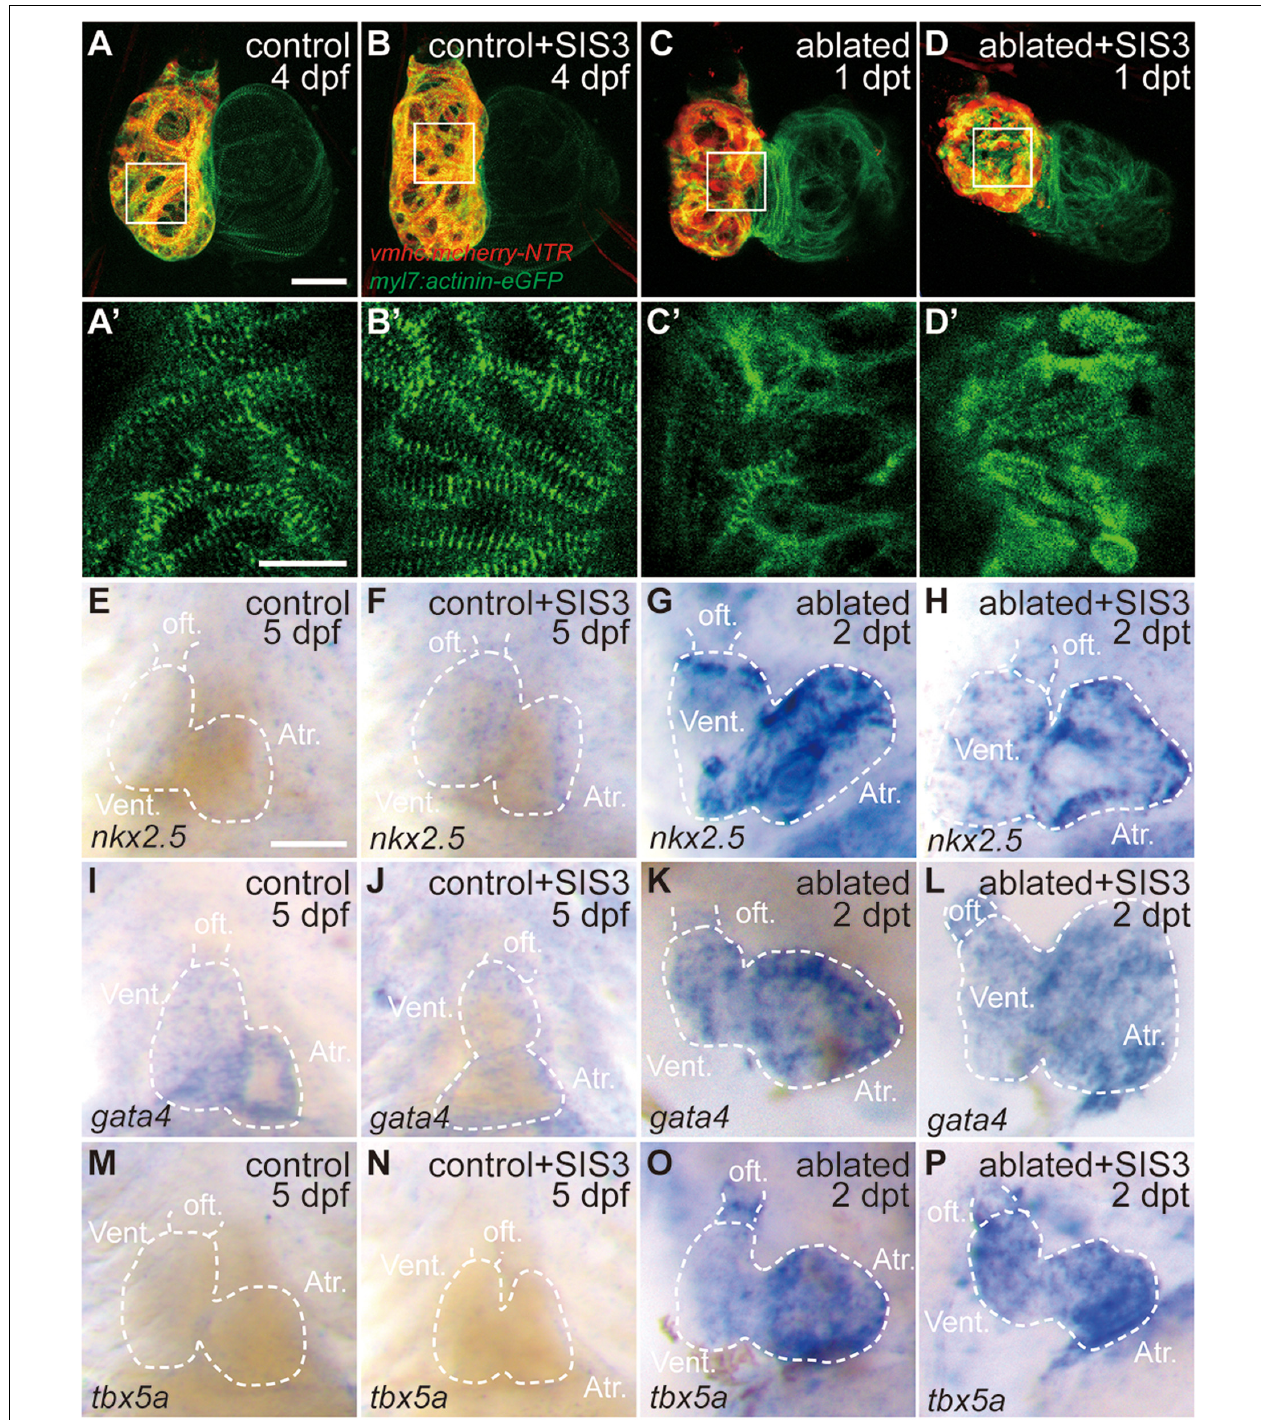
FIGURE 3 | Smad3 inhibition has limited effects on sarcomere disassembly and cardiogenic factor reactivation during regeneration. (A–D (cid:48) ) Representative fluorescence images of Tg(vmhc:mCherry-NTR; myl7:actinin-eGFP) hearts at 4 dpf/1 dpt indicate that sarcomere disassembly occurred in the ablated hearts (C,C (cid:48) ) and SIS3-treated ablated hearts (D,D (cid:48) ) . (A (cid:48) –D (cid:48) ) Enlargement of box areas in panels (A–D) , green channel only. (E–P) Whole-mount in situ hybridization showing the expression level changes of cardiogenic factors nkx2.5 , gata4 , and tbx5a during regeneration. Smad3 inhibition via SIS3 treatment could abolish the reactivation of nkx2.5 at 5 dpf/2 dpt (G,H) but has no effect on the reactivation of gata4 and tbx5a (K,L,O,P) . Dashed lines outline the hearts. Scale bars (A–D,E–P) 50 µ m and (A (cid:48) –D (cid:48) ) 20 µ m. dpf, days post-fertilization; dpt, days post-treatment; atr., atrium; oft., out flow tract; vent., ventricle.